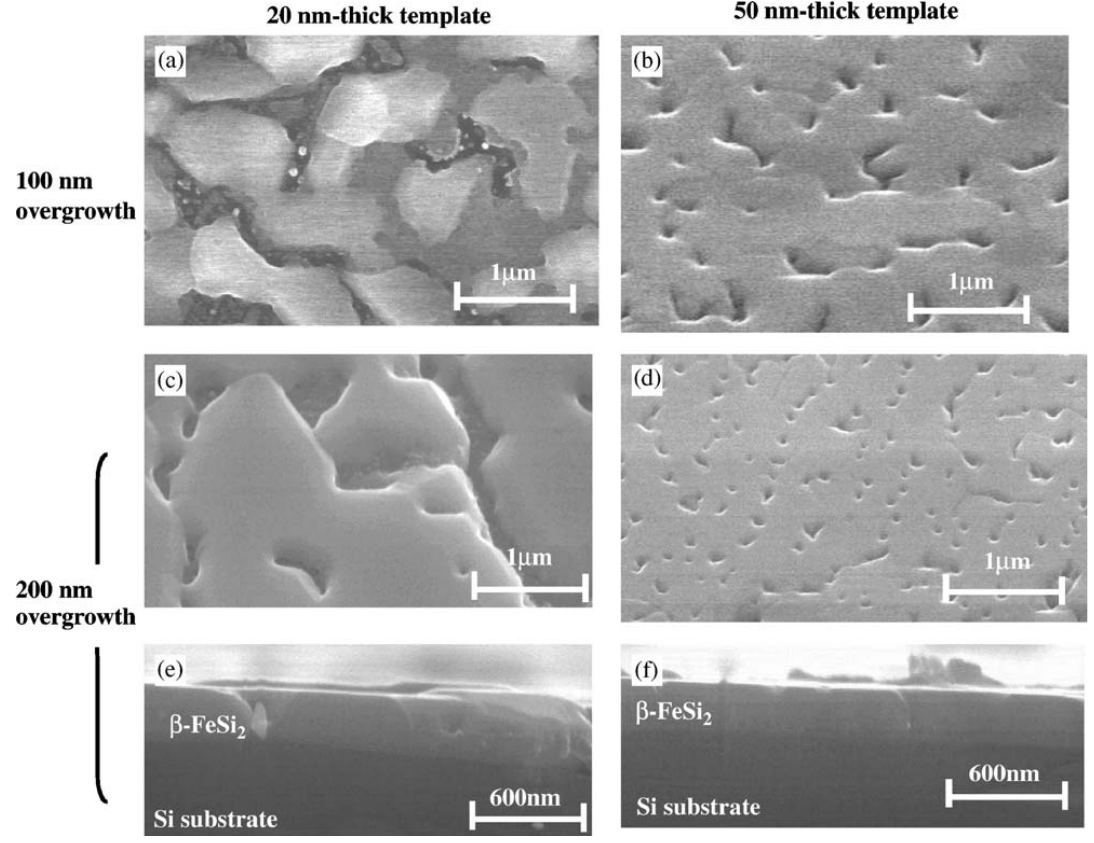
16. (a)–(d) Pane-view and (e) and (f) cross-sectional SEM images of MOCVD-overgrown films deposited on Si (111) substrates with ((a), (c), (e)) 20- or ((b), (d), (f)) 50-nm-thick templates; (a) and (b) after 100 nm MOCVD-overgrowth at 750 °C; (c)–(f): after 200 nm MOCVD-overgrowth at 750 °C. Reproduced from Ref. [106] with permission from